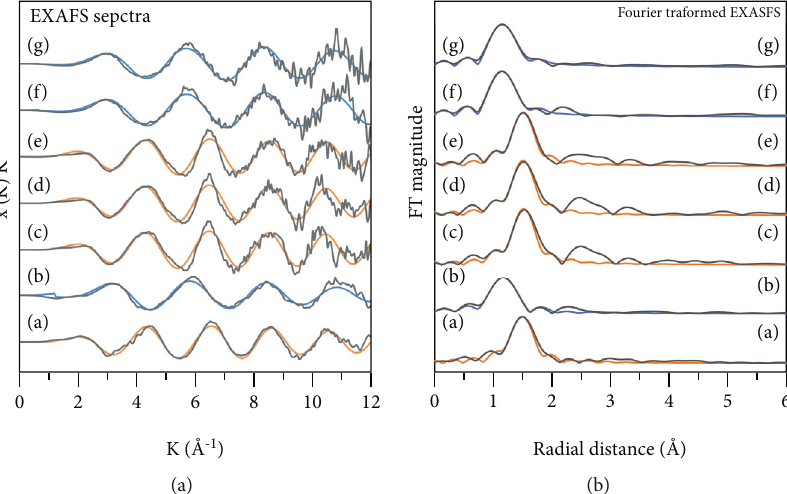
Figure 5: EXAFS spectra and Fourier transform EXAFS of powder references and powder samples included the (a) Cr(III) reference, (b) Cr (VI) reference, (c) NTB+Cr(III), (d) 1HDTMA+Cr(III), (e) 1CPC+Cr(III), (f) 1HDTMA+Cr(VI), and (g) 1CPC+Cr(VI). The black lines are raw data, and the color lines are fi tted